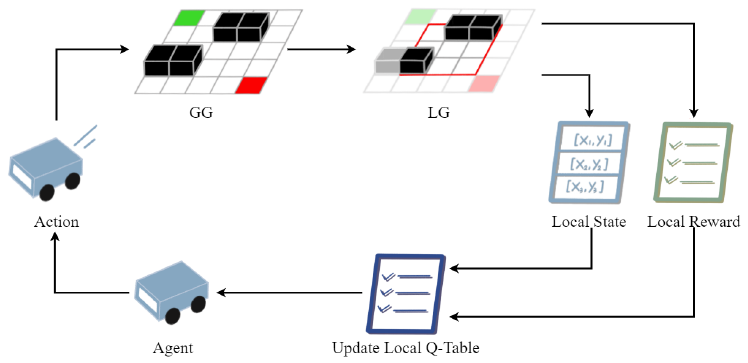
Figure 2. Learning policy of the